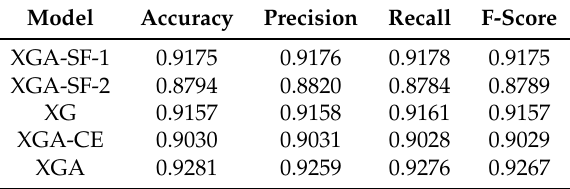
Table 2. The results of ablation study.